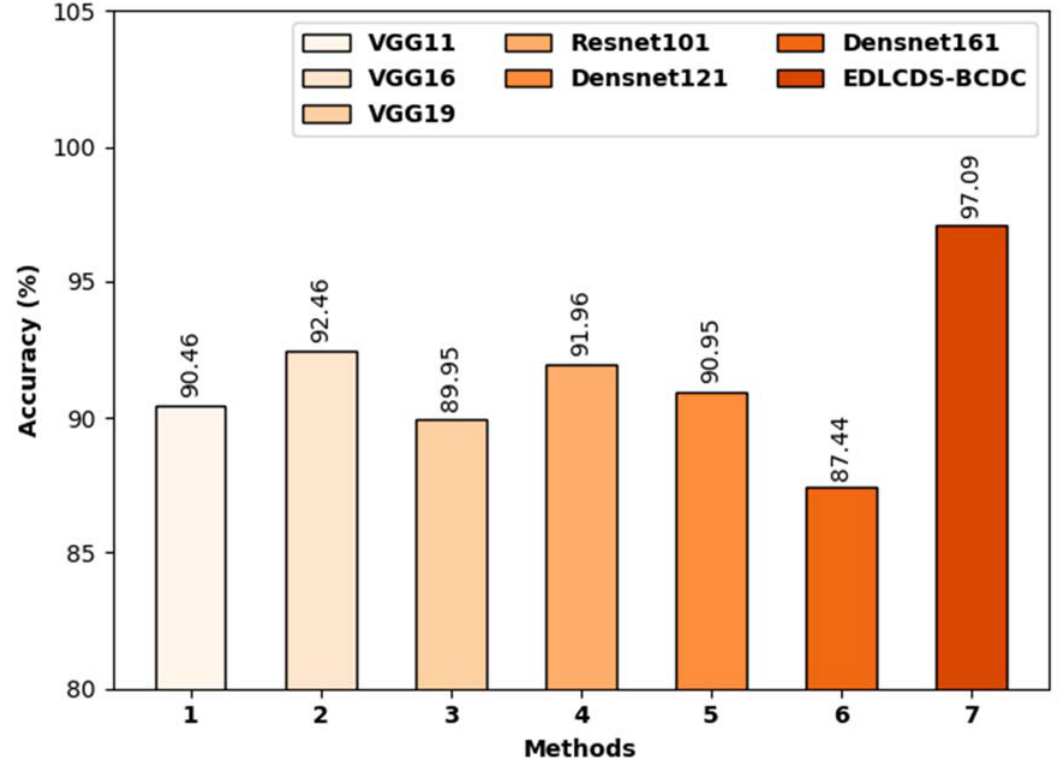
Figure 10. Accuracy analysis of the EDLCDS ‐ BCDC technique compared with recent methods.